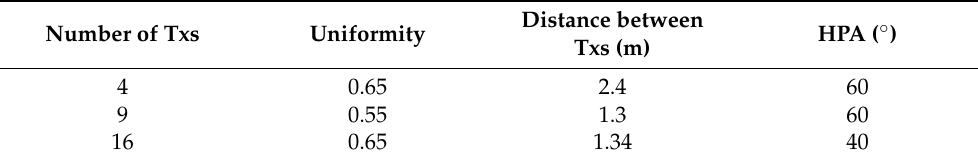
Figure 9. Comparison of ε p for different Txs and uniformity. Table 3. The optimized values for all cases of